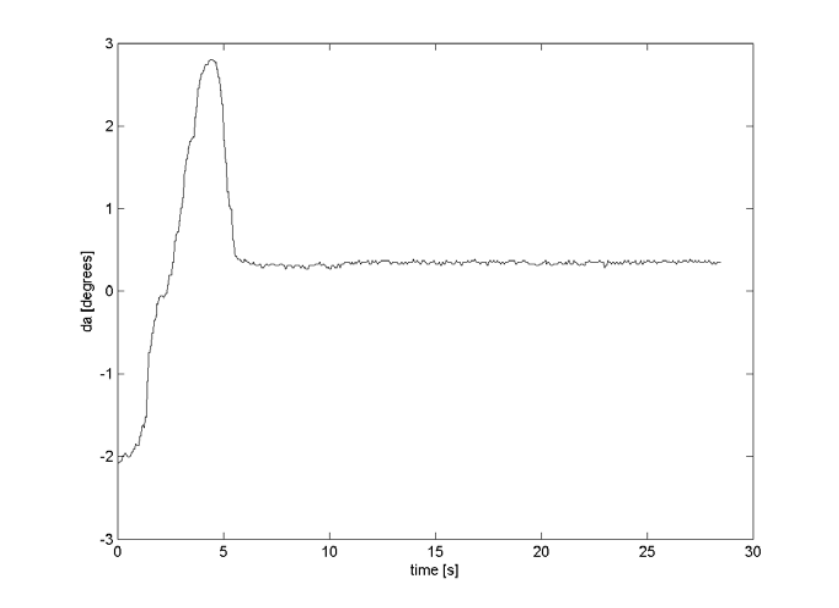
Fig. 6. Aileron deflections for the Dutch-roll